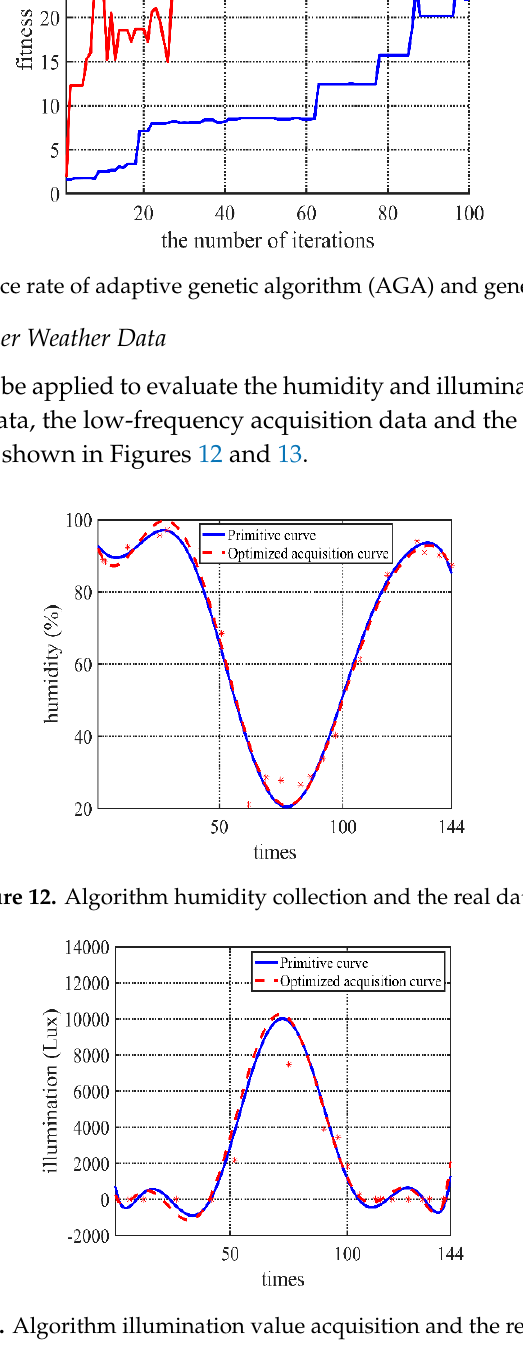
11 of 13 Table 1. Different FIT max , acquisition frequency and error. FIT max